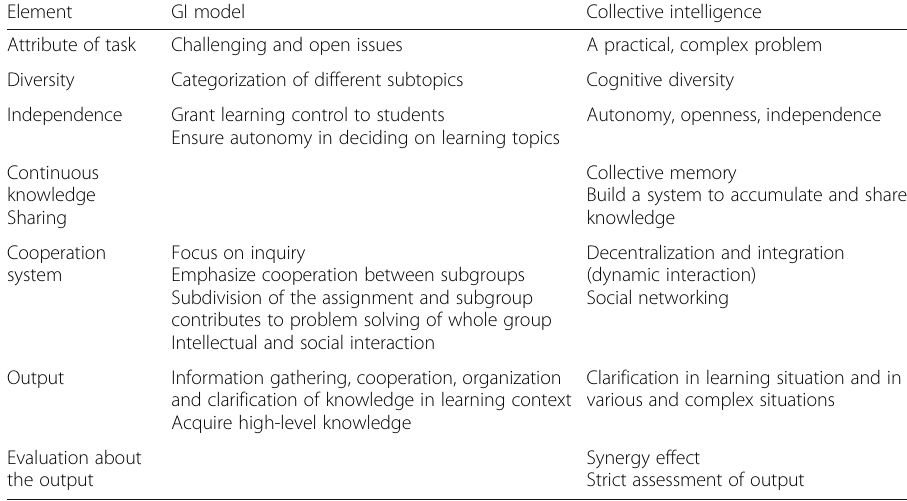
Table 4 Comparison of GI model and collective intellectual attributes Element GI